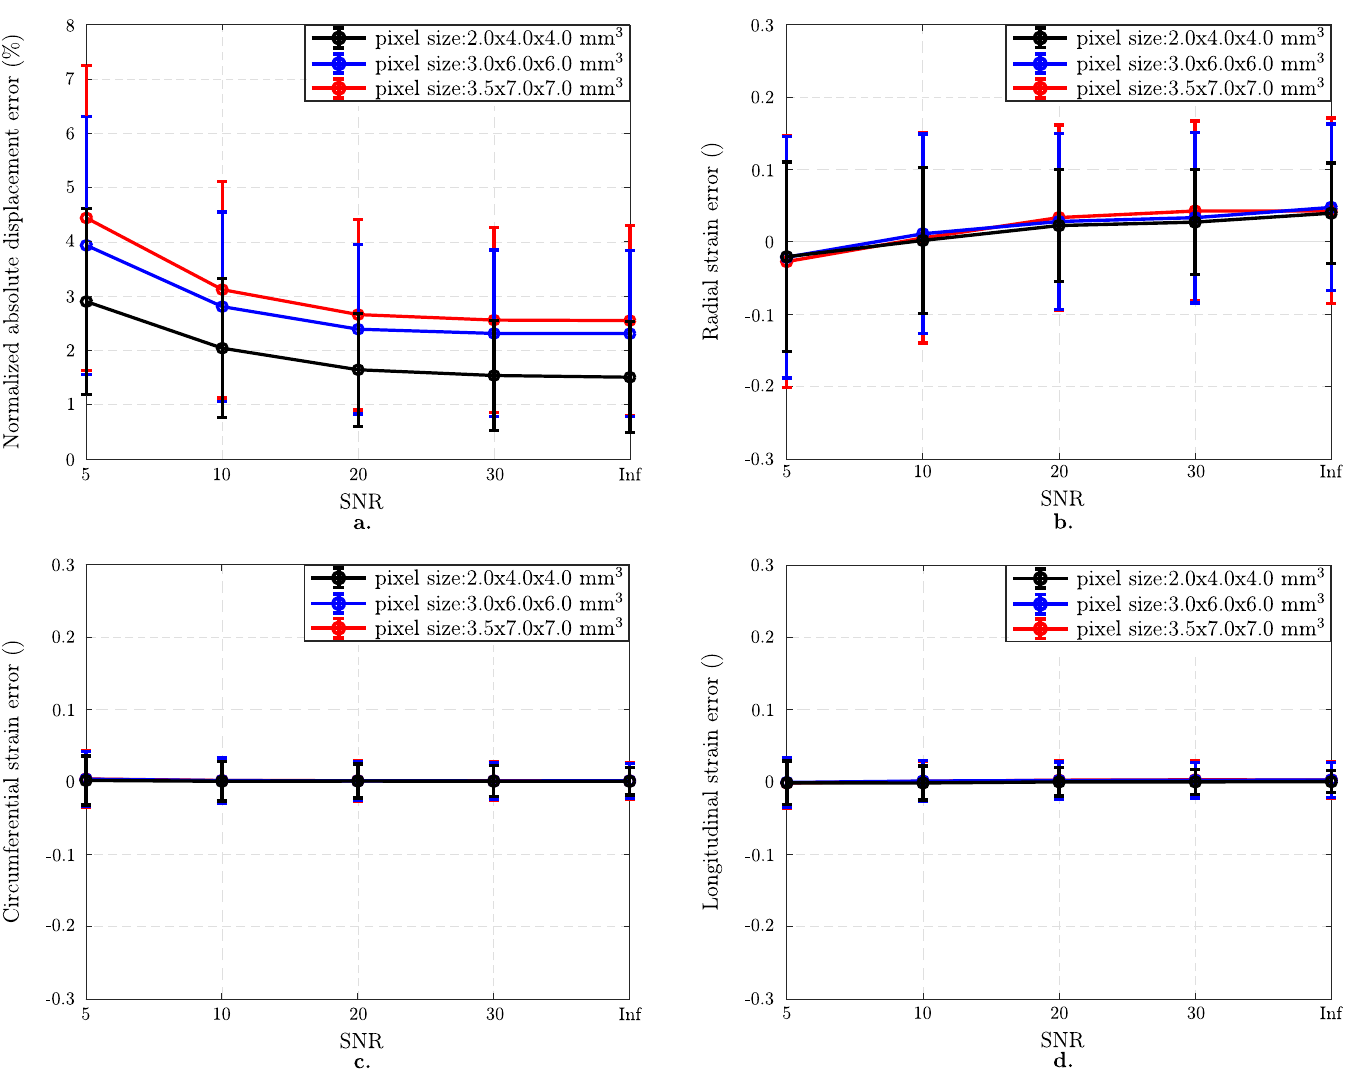
Fig 8. Combined effect of image resolution and SNR on anisotropically resolved image analysis. Results on images with 7 mm tag distance. Normalized mean ± standard deviations in displacement error norm (%) plotted as a function of SNR for different pixel sizes (a). Mean ± standard deviations in component-wise Green-Lagrange strain error as a function of SNR and pixel size (b-d). Combined effect of increased pixel size and decreased SNR is more pronounced on the radial strain component (b) while there is almost no change in the circumferential (c) and longitudinal (d) components.